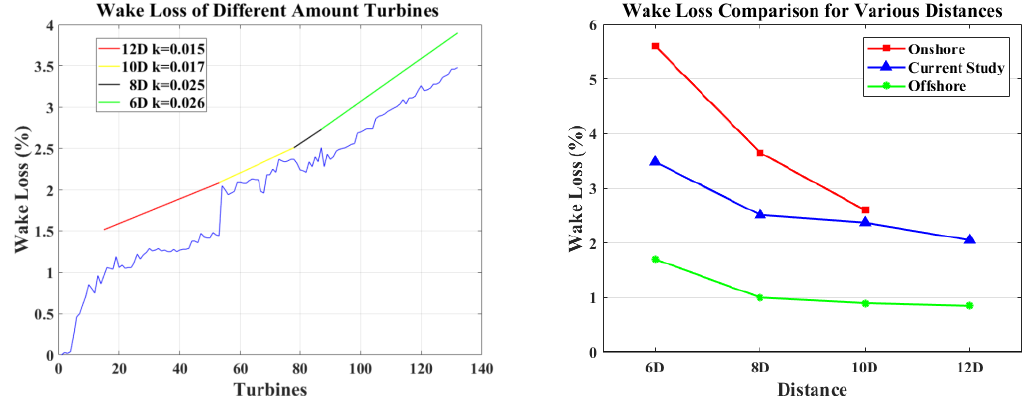
Figure 9. Wake loss for different numbers of turbines in wind farm and for various inter-turbine distances compared to the values obtained in onshore and offshore simulations.